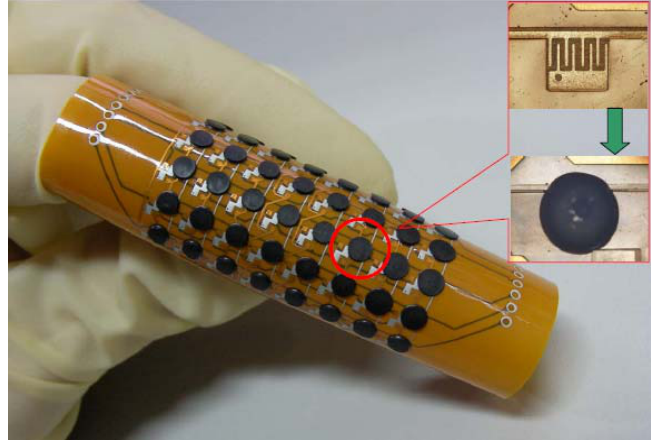
Figure 6. Fabricated flexible temperature sensor array. The insets show the interdigitated electrode and composites on the electrode,